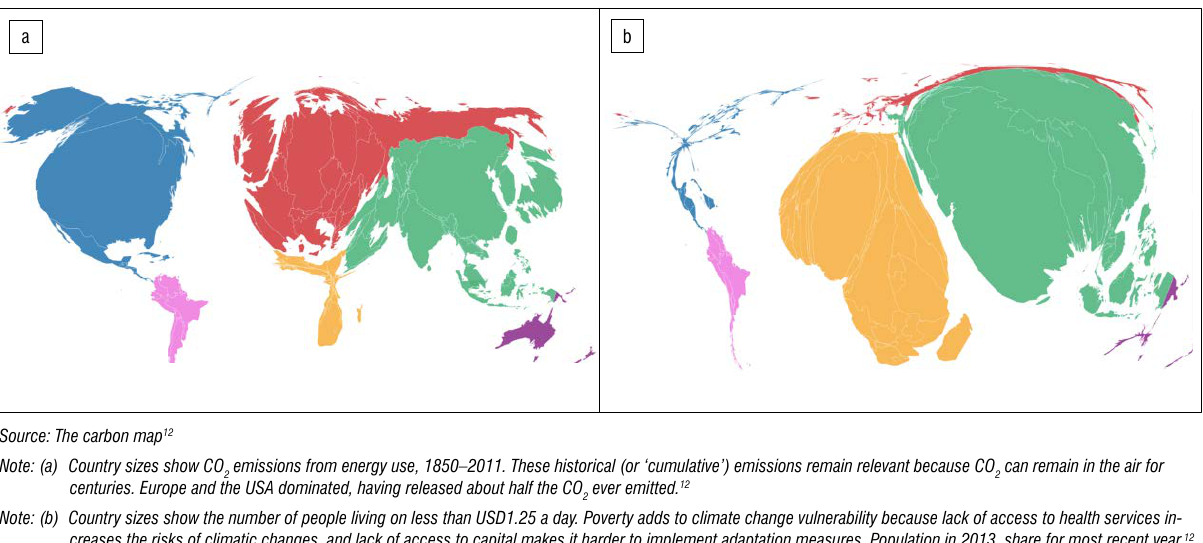
figure 2: World maps showing areas of countries adjusted by (a) cumulative energy CO